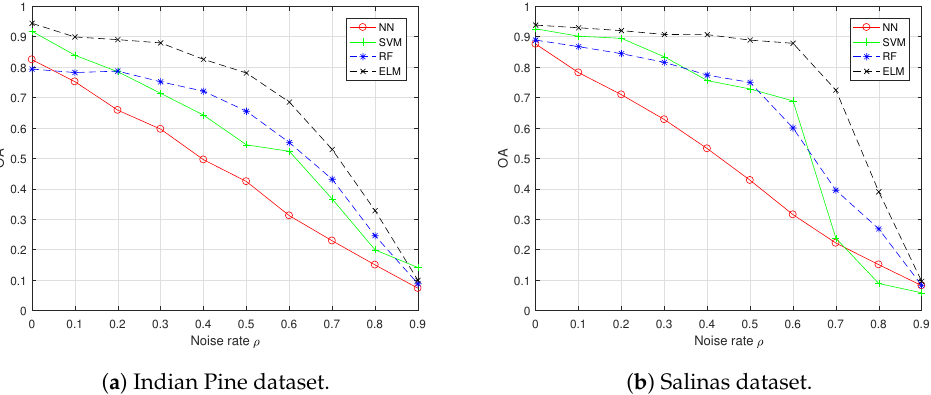
Figure 2. The OA of NLA over four typical classifiers at different noise rate on two standard hyperspectral datasets. The results of NN, SVM, RF and ELM are labeled in red “o”, green “+”, blue “*”, and black